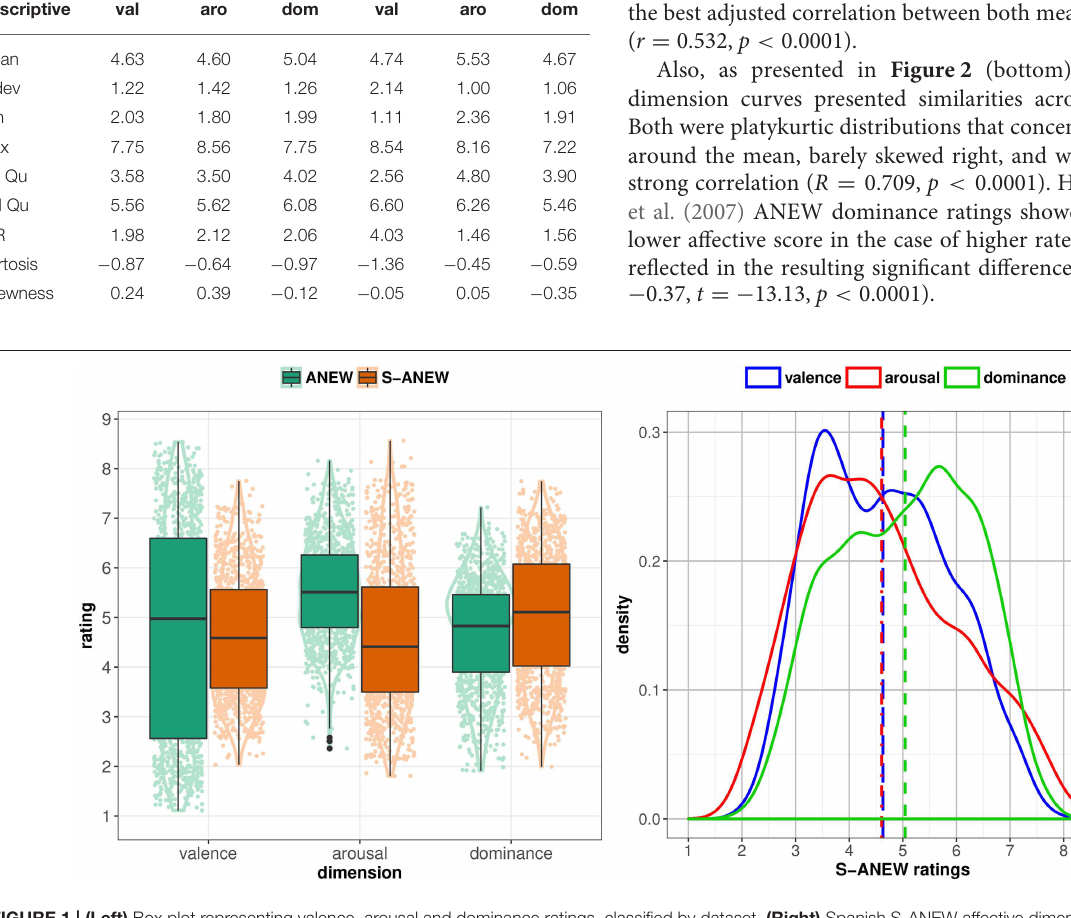
Frontiers in Psychology |